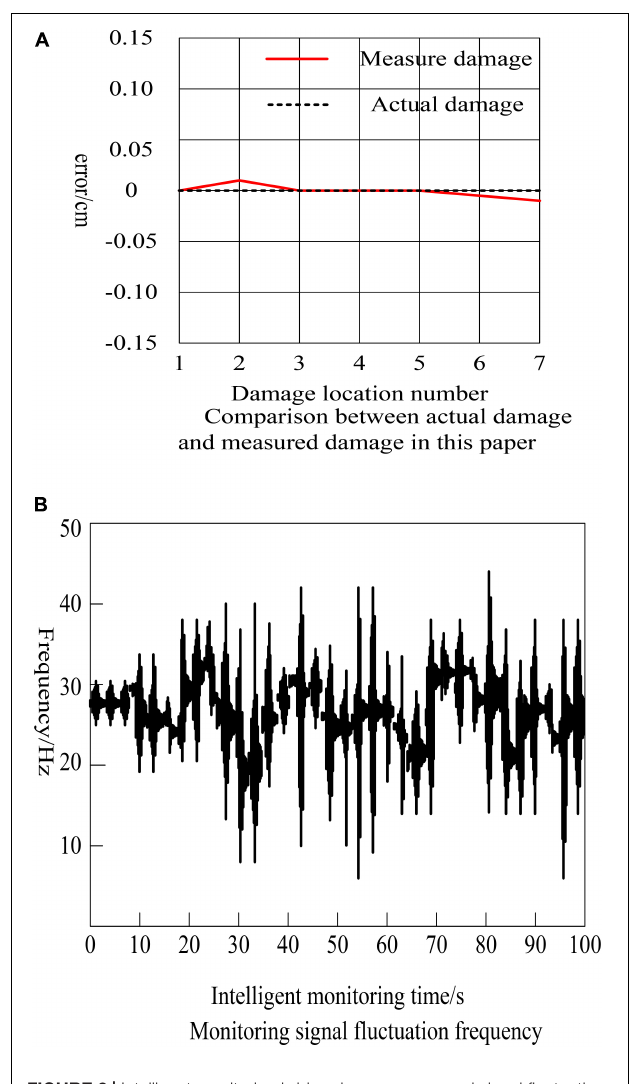
FIGURE 2 | Intelligent monitoring bridge damage curve and signal fluctuation frequency. (A) Comparison between actual damage and measured damage in this paper. (B) Monitoring signal fluctuation